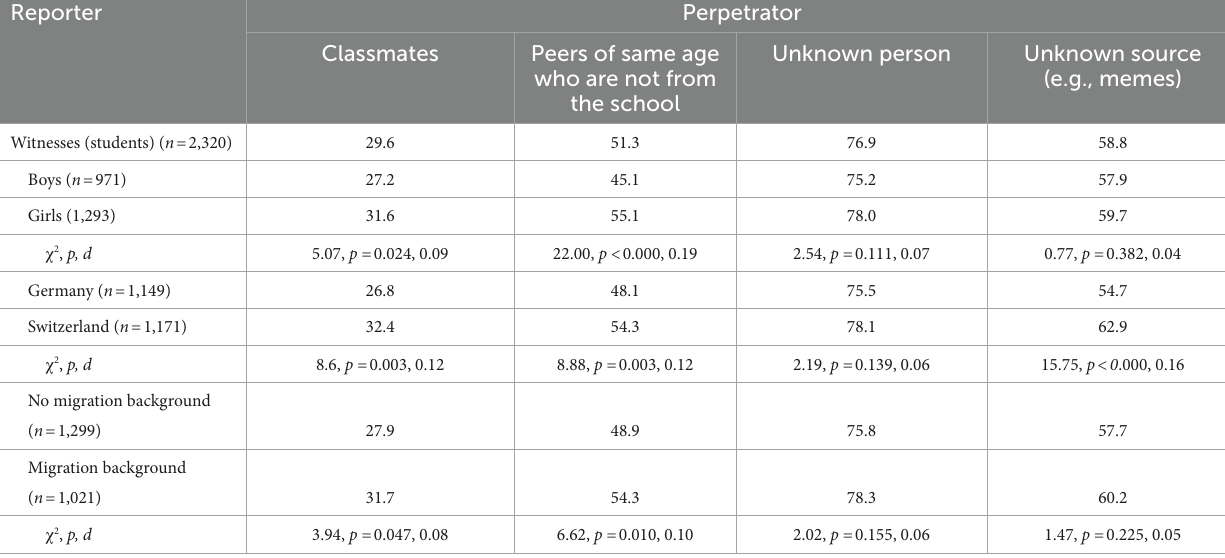
TABLE 4 Perpetrators of online hate speech by country, gender, and migration status of the witnesses.